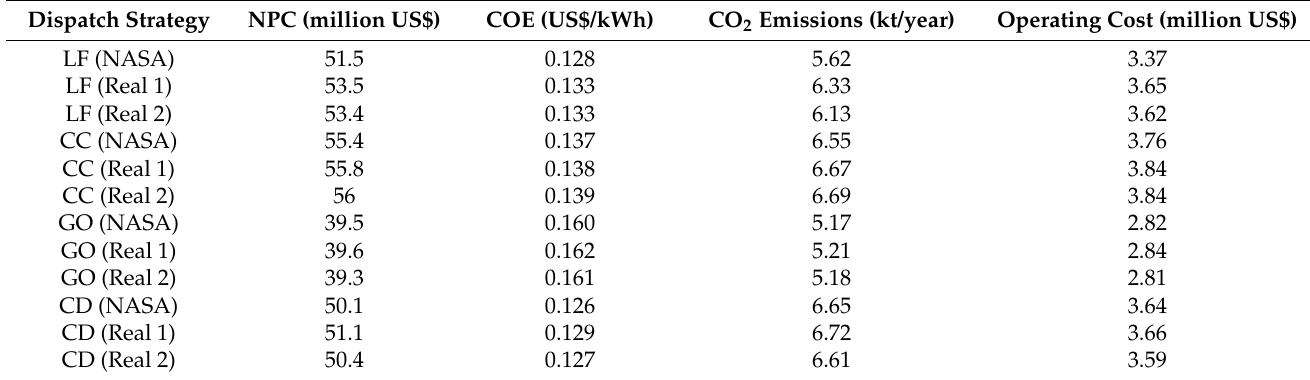
Table 1. Comparison of NPC, COE, and CO 2 emission according to the four dispatch strategies for three different cases. Dispatch Strategy NPC (million US$) COE (US$/kWh) CO 2 Emissions (kt/year) Operating Cost (million US$) LF